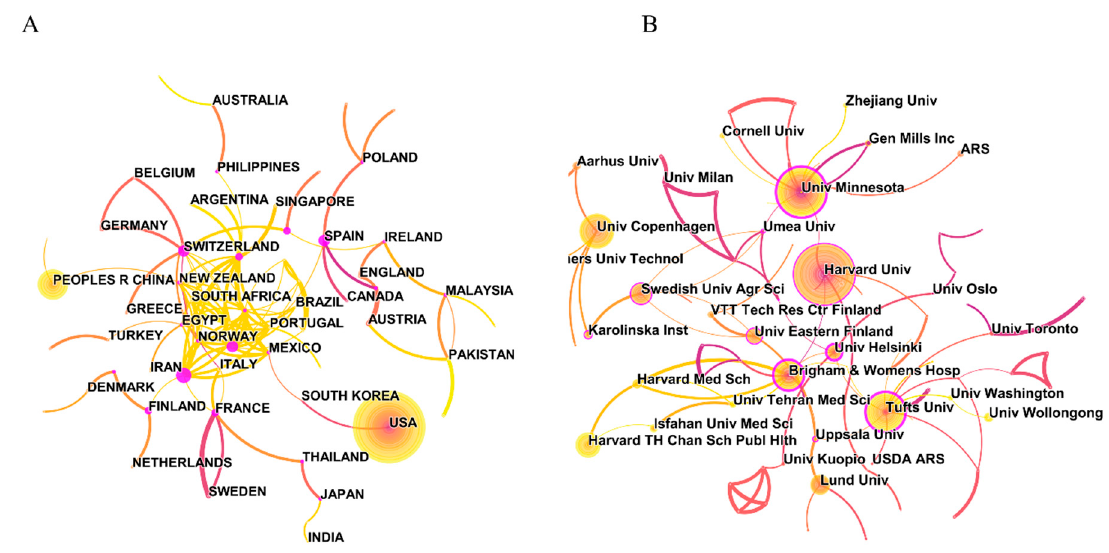
of whole Figure 2. Collaborations of ( A ) countries/regions and ( B ) institutions for studies on the health effects of whole grains.